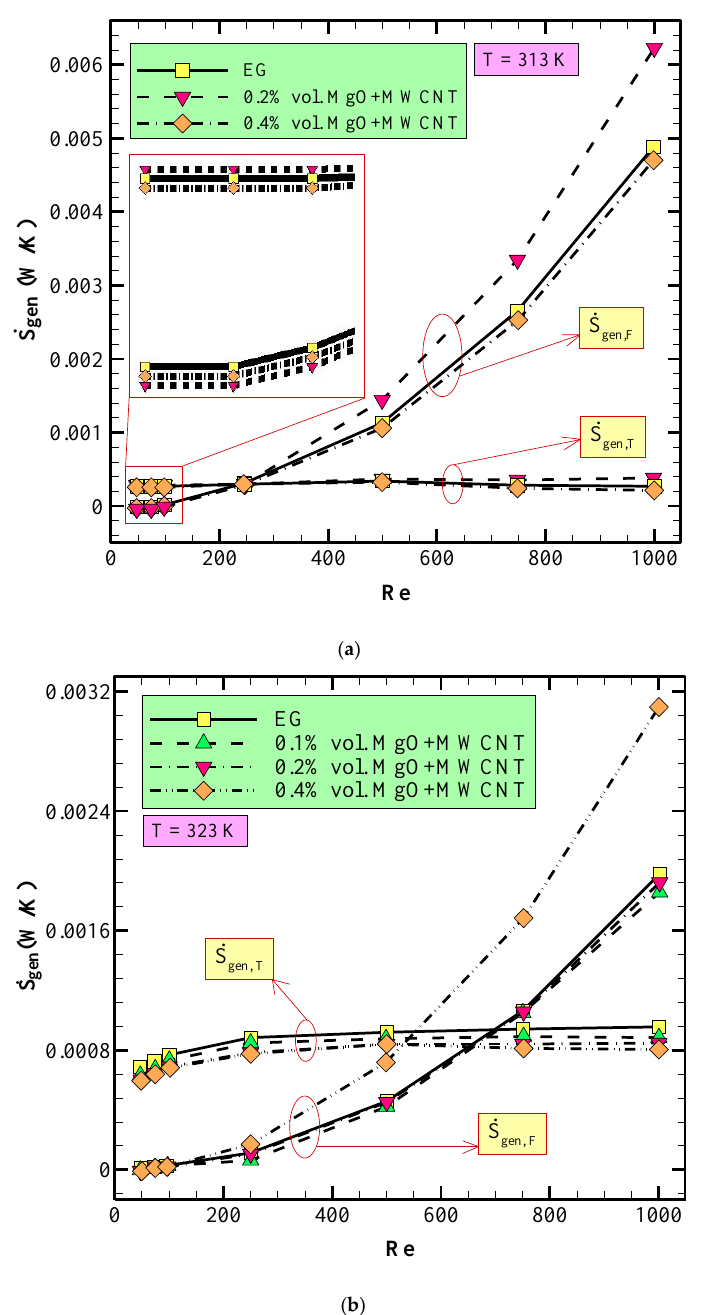
Figure 17. Effects of HNF with different VF on entropy generation for different Re and inlet temperatures ( a ) T = 313 K and ( b ) T = 323 K.